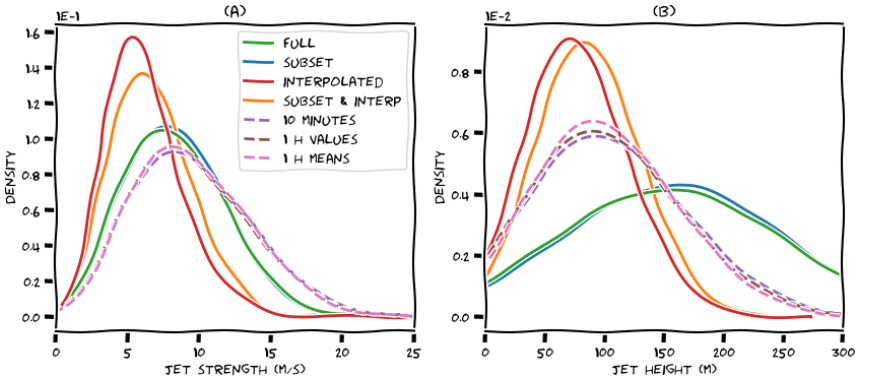
Figure 5. Kernel density estimates of the probability distribution of jet strength (a) and jet height (b) for various representations of the ERA5 data (full lines) and the observations (dashed lines), aggregated over all